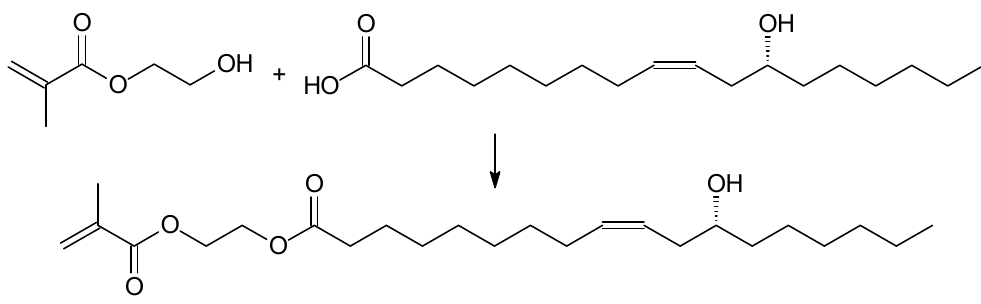
Figure 3. Schematic of synthesis of methacrylated ricinoleic acid monomer.